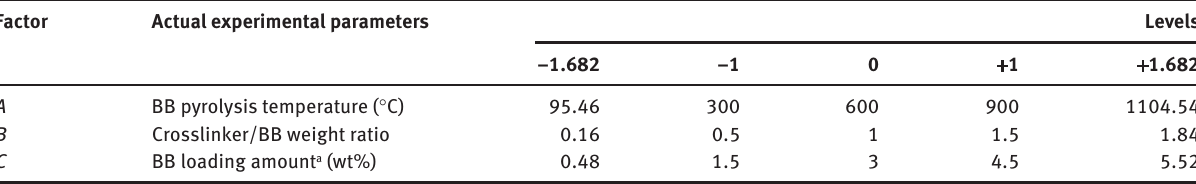
Table 1: Experimental factors and levels investigated in this study.